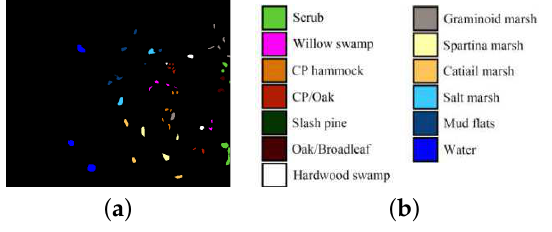
Figure 5. ( a , b ) Ground truth data of the Kennedy Space Center